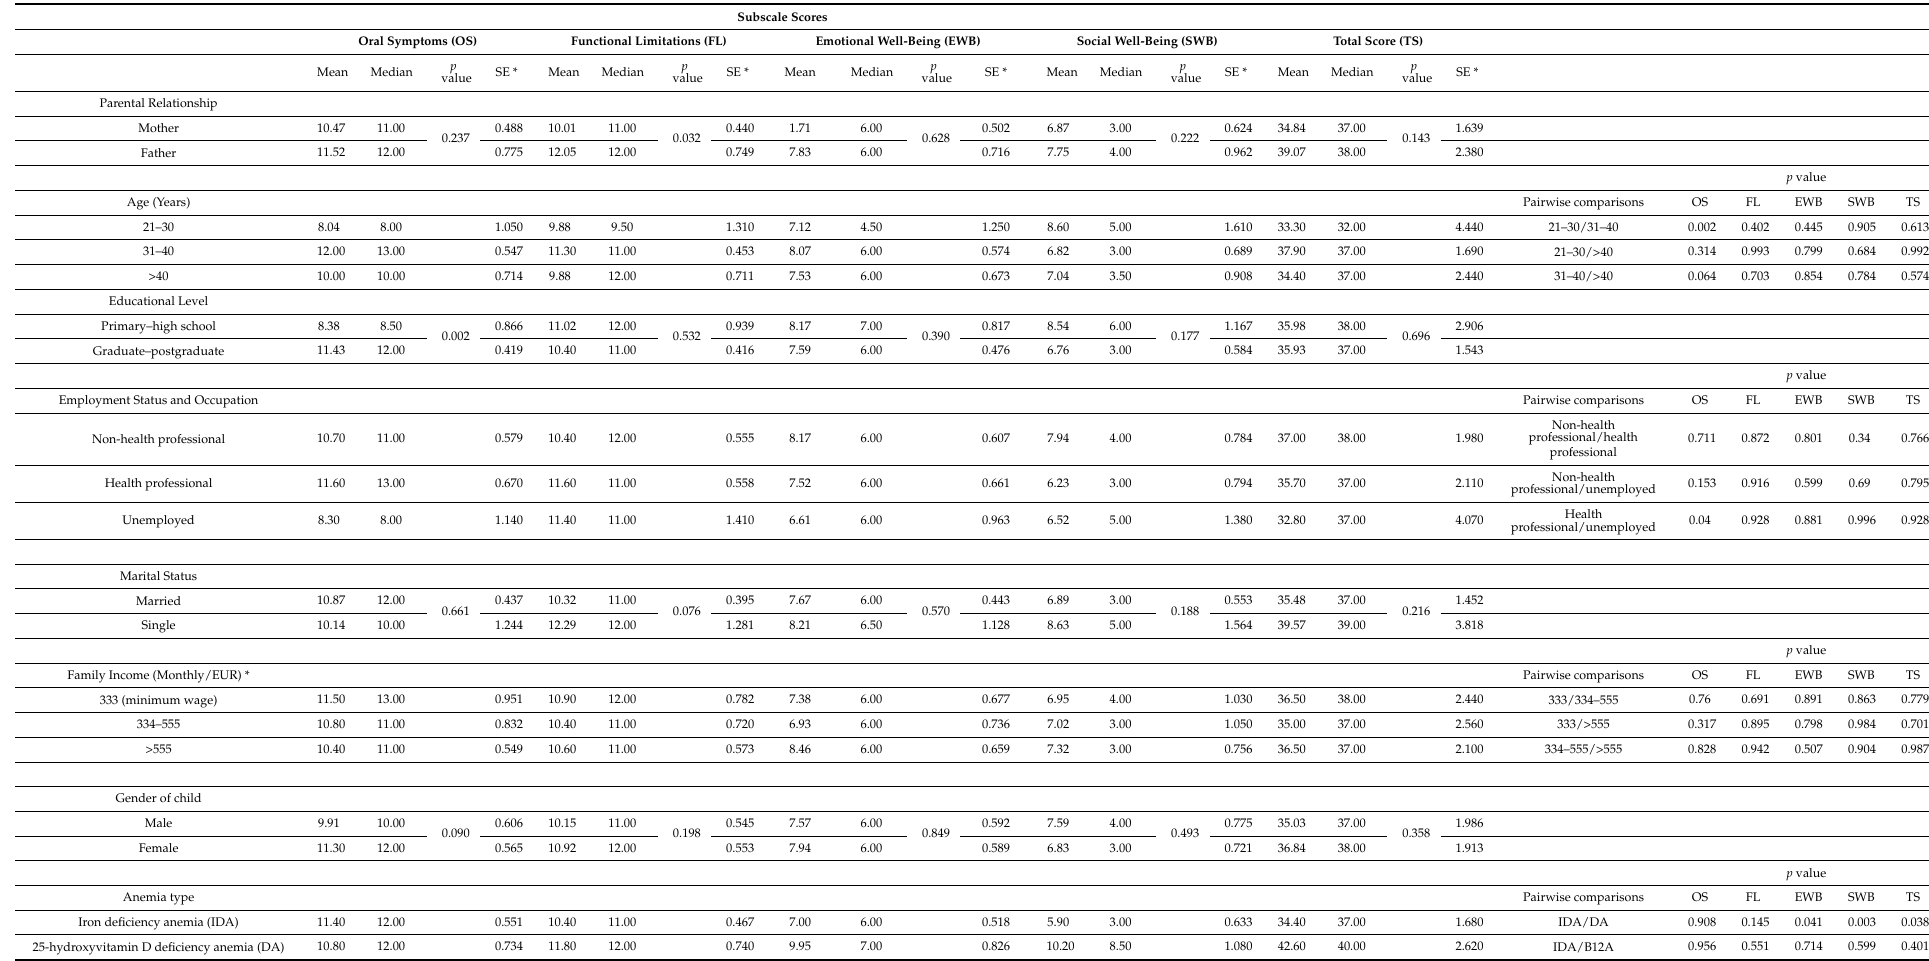
Table 4. Association between overall and subscale scores of Parental Caregiver Perception Questionnaire (P-CPQ) with demographic